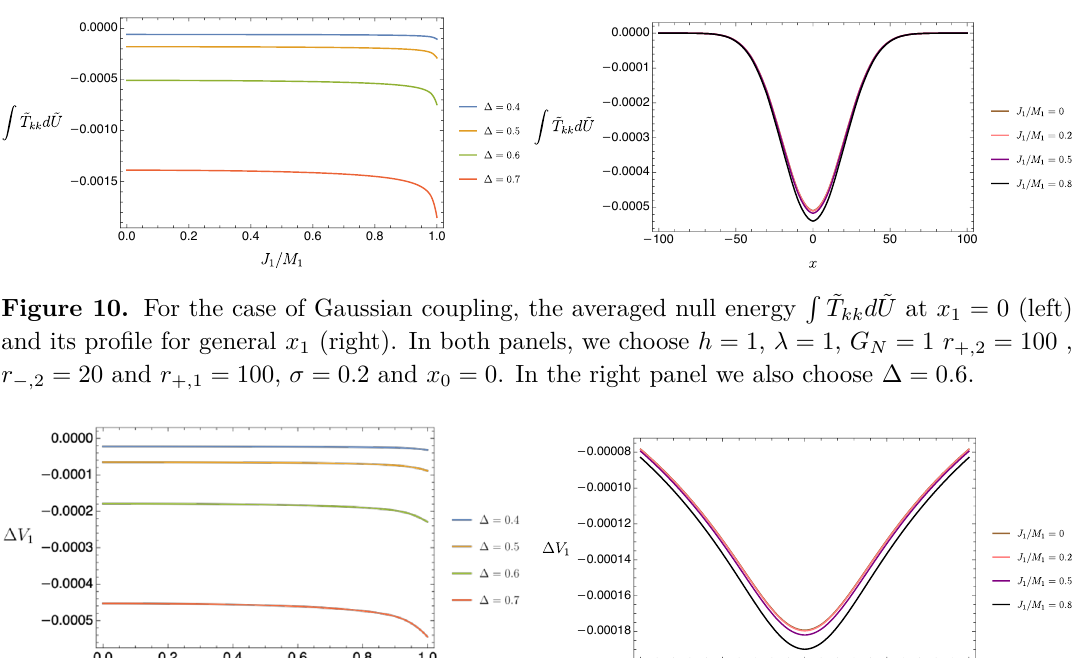
Figure 11. For the case of Gaussian coupling, the shift of horizon ∆ V 1 at x 1 = 0 (left) and its profile for general x (right). In both panels, we choose h = 1 , λ = 1 , G 1 and r = 100 , σ = 0 . 2 and ˜ x = 0 . In the right panel we also choose ∆ = 0 . 6 + , 1 0